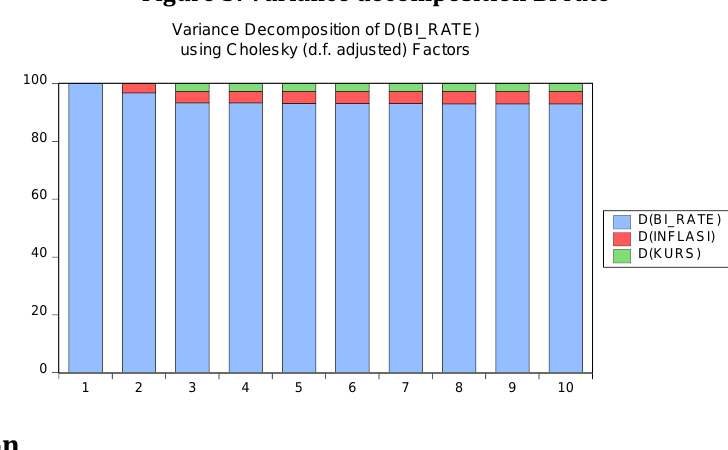
Figure 3: Variance decomposition BI rate